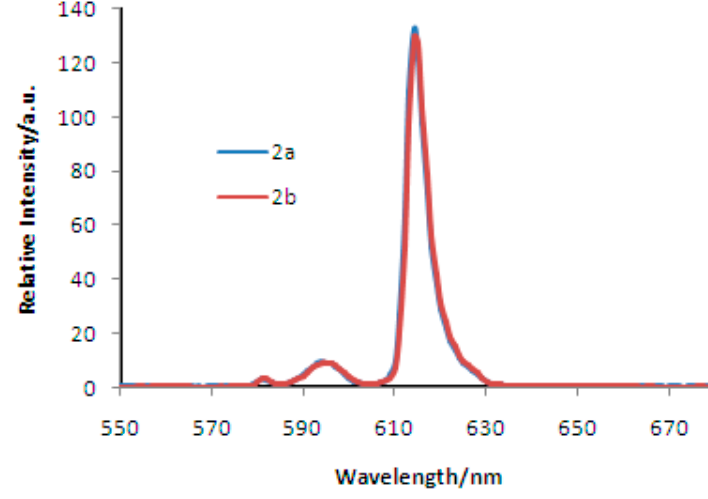
Figure 2. UV-Visible spectra of the complexes 2a and 2b .